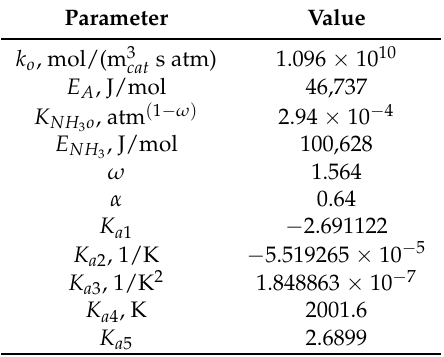
Table 2. Ammonia synthesis reaction rate expression parameters.